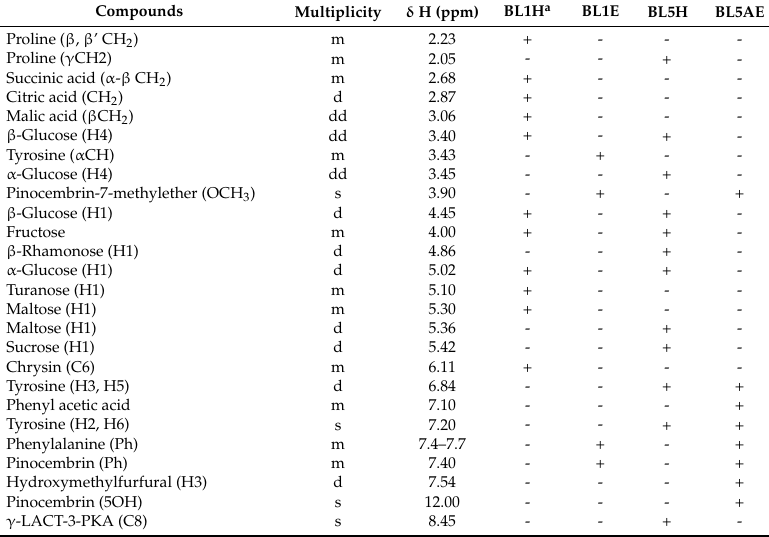
Table 2. 1 H-NMR qualitative analyses of honey